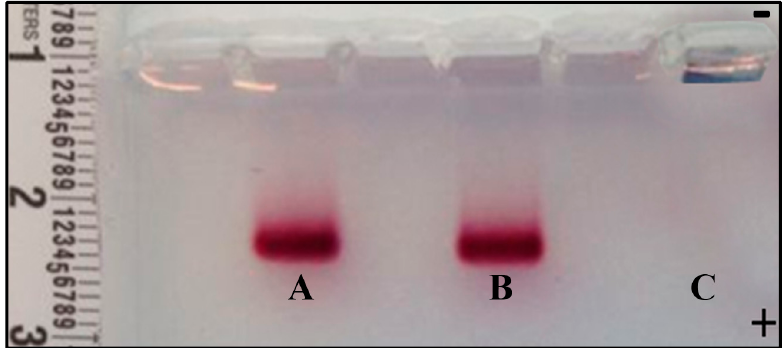
Figure 6. Electropherograms of AuNPs + β -CD/MTX ( A ), AuNPs + MTX ( B ), and AuNPs ( C ) on 1.0% agarose gel.